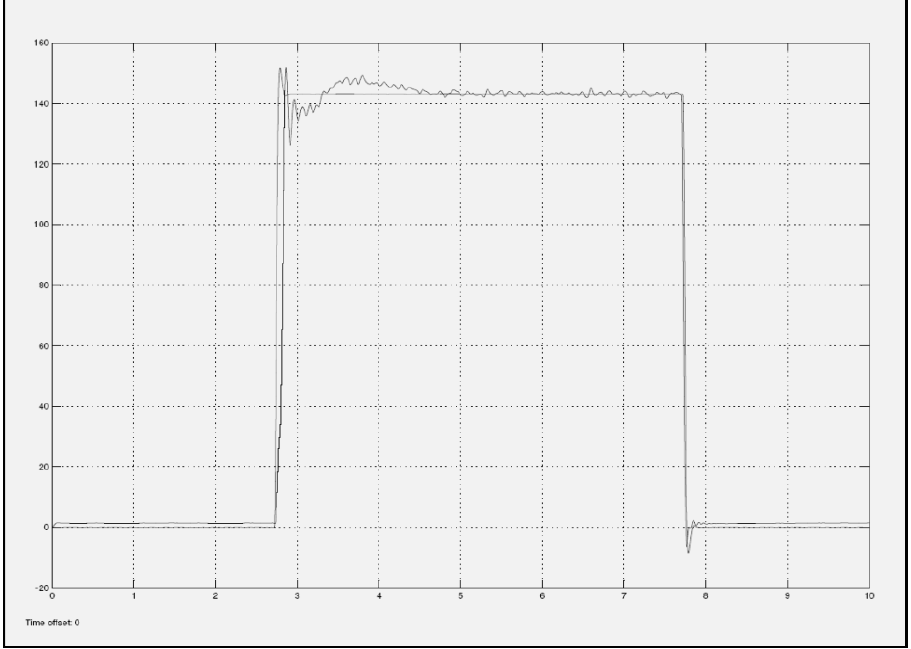
Figure 9. Good EFC Valve with 1.8 Amps current input.